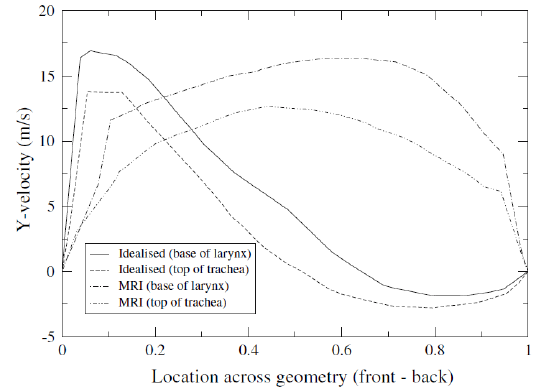
Figure 5. Comparison of the Idealize model with the MRI model. Reprinted with permission from Ref. [46]. 2007, T. P. Collins et al.